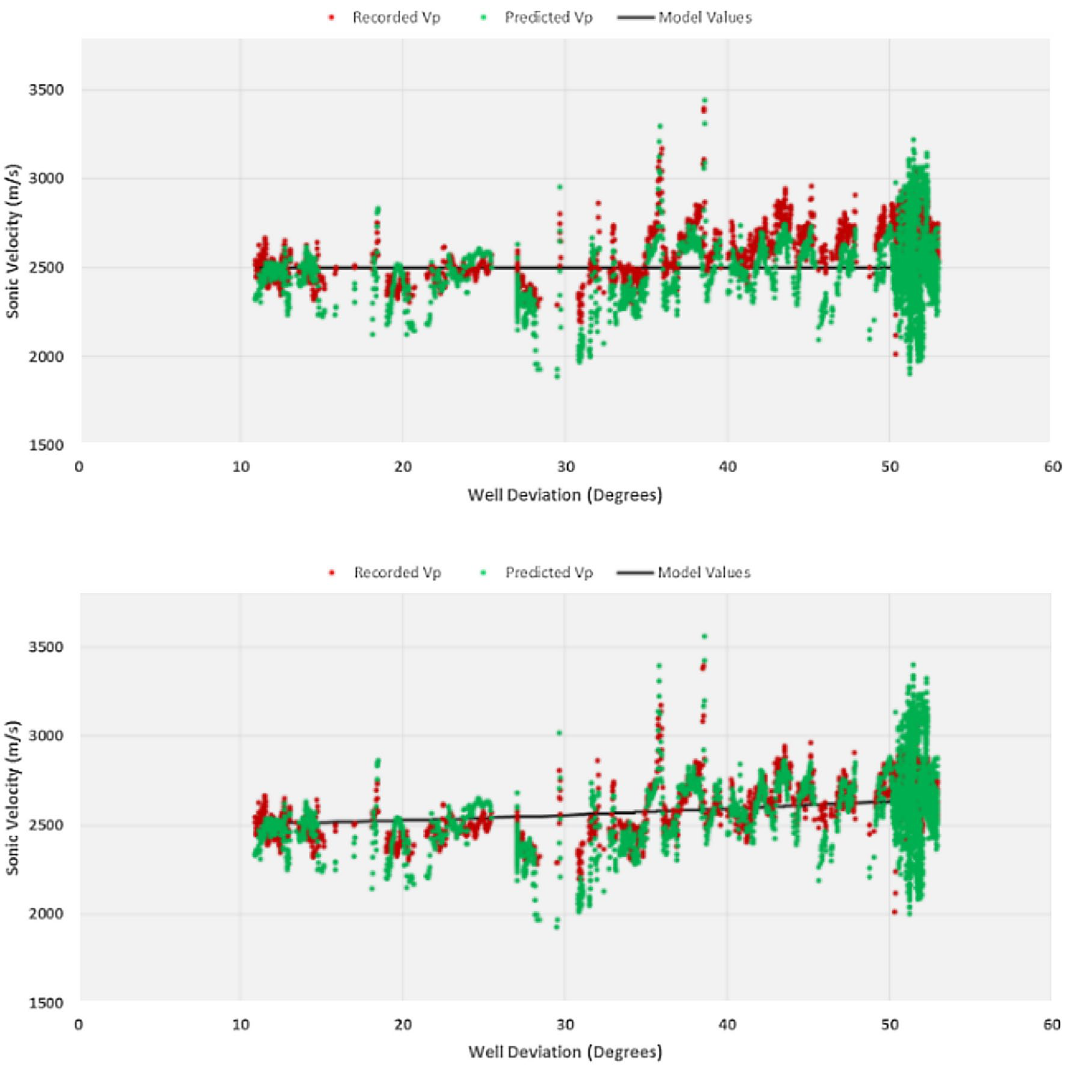
Fig. 6 Compressional velocities plot against well deviation. The green curve on the upper figure is the predicted vertical velocity. The green curve in the lower figure is the vertical velocity after applying the Thomsen’s anisotropy